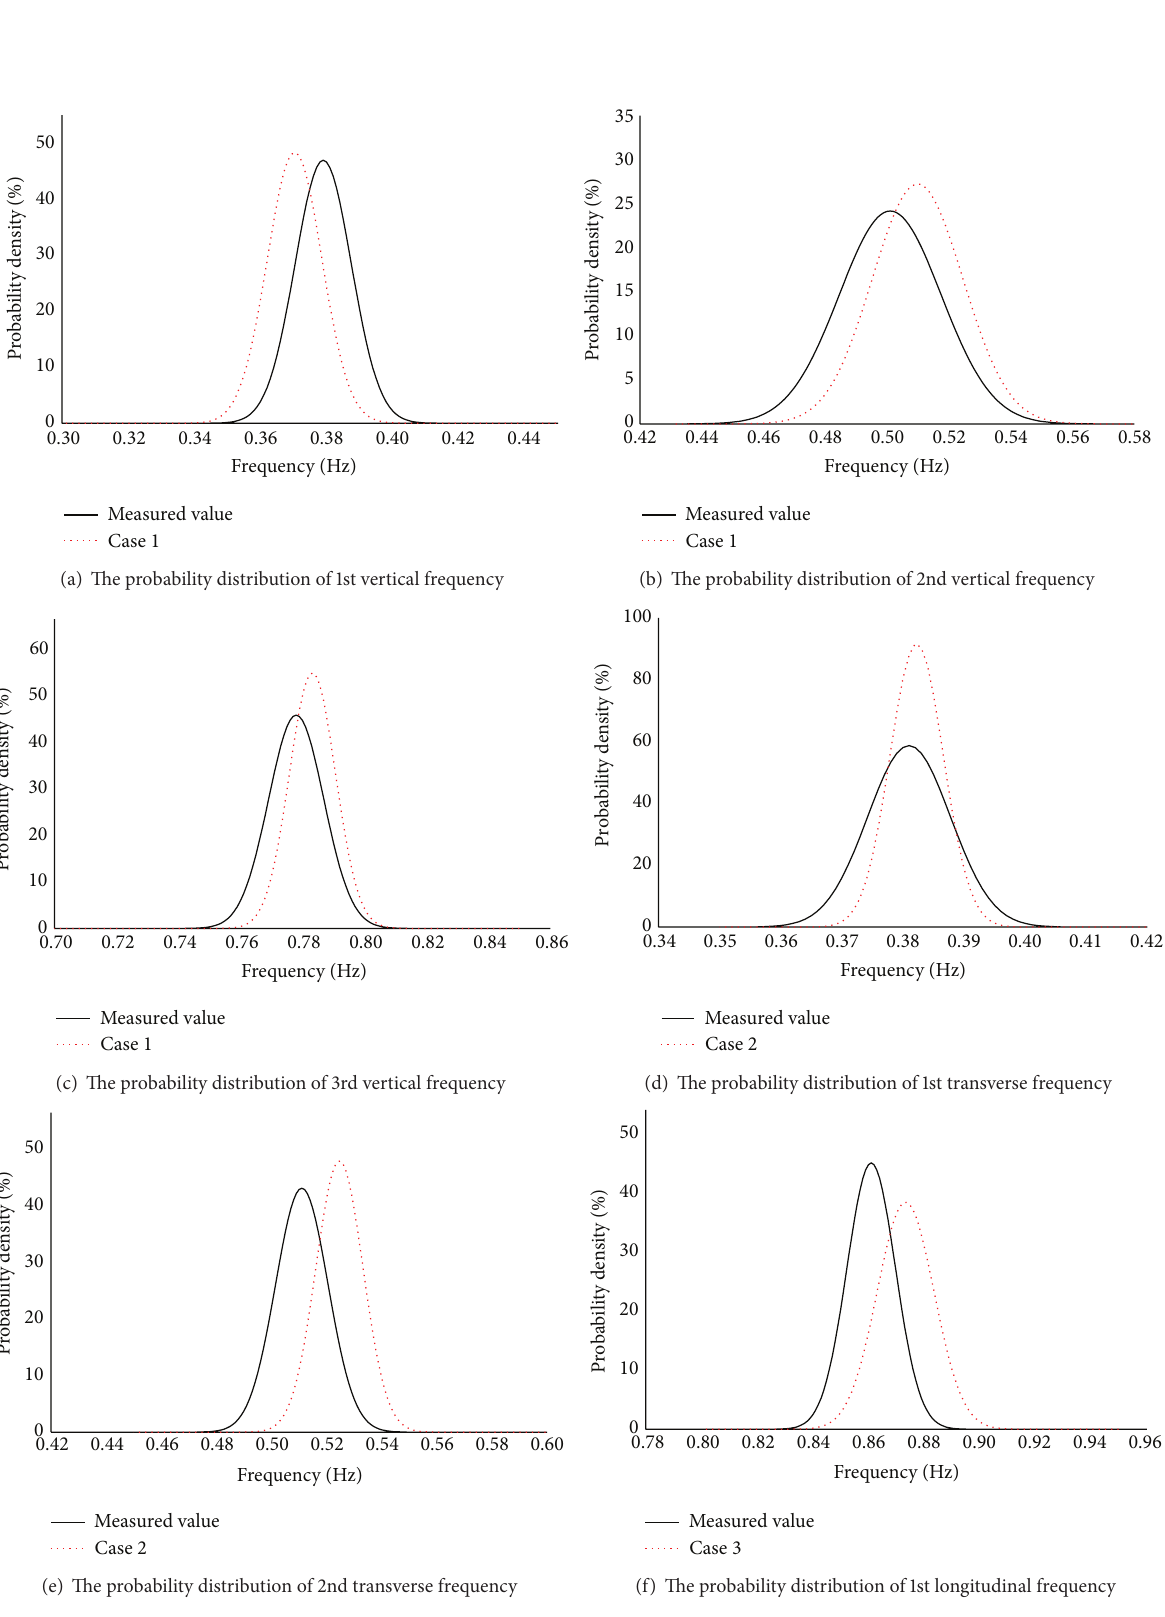
Figure 10: The probability distribution of Guanhe Bridge